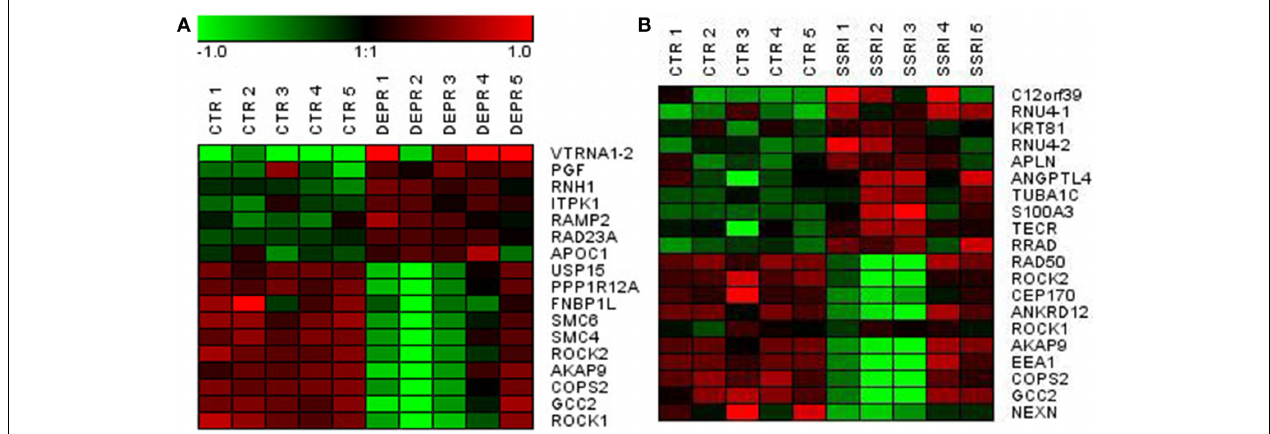
FIGURE 1 | Visualization of differentially expressed genes using hierarchical clustering of genes in depressed (A) and SSRI-treated (B) vs. control fetal placentas.